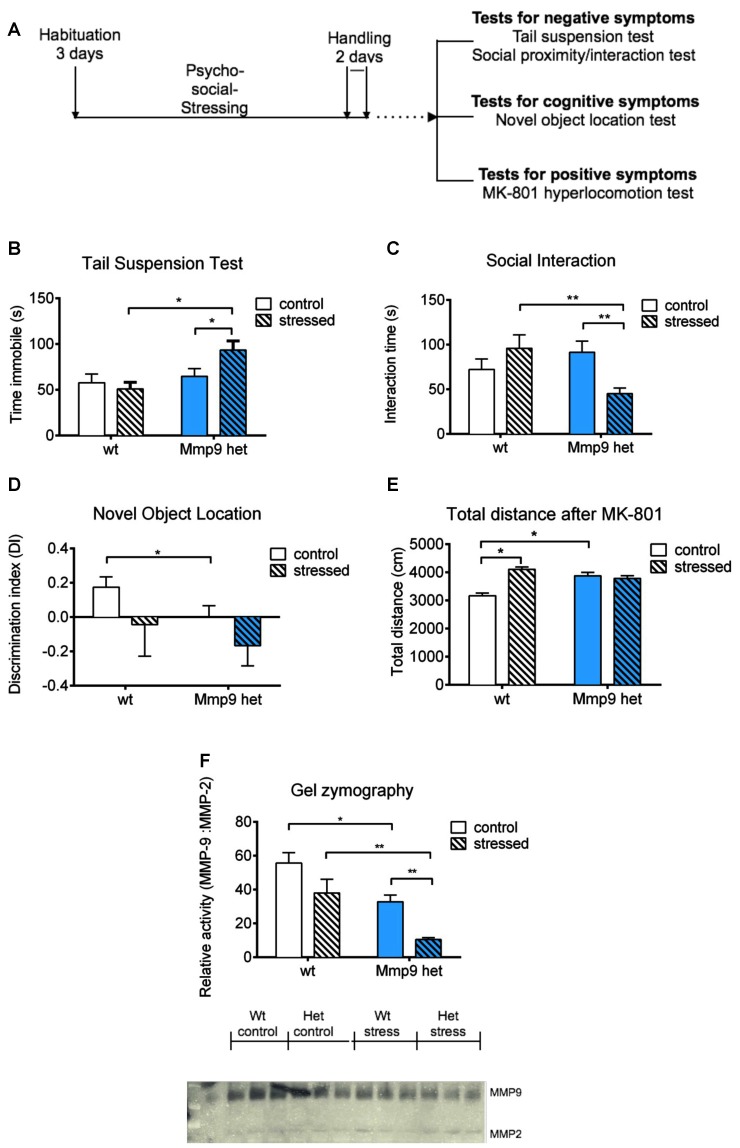
(A) Schematic diagram of the experiment. (B) Tail suspension test. Stressed Mmp-9 heterozygous mice had a longer duration of immobility [individual t-test, p < 0.05; two-way analysis of variance (ANOVA), F(1,37) = 7.008, p < 0.05] compared with their non-stressed counterparts and stressed wt mice. (C) Social interaction test. The time spent interacting with unfamiliar mice decreased in stressed heterozygous mice (individual t-test, p < 0.05; two-way ANOVA, F(1,37) = 8.9555, p < 0.05) compared with their non-stressed counterparts and stressed wt mice. (D) Novel object recognition test. Mmp-9 heterozygous mice spent less time with the novel object (individual t-test, p < 0.05) compared with wt mice. (E) Treatment with MK-801 increases the distance traveled in the open field in heterozygous mice and stressed wt mice (individual t-test, p < 0.05; two-way ANOVA, F(1,37) = 14.61, p < 0.005) compared with non-stressed wt mice. (F) Gel zymography and relative densitometric plot of matrix metalloproteinase-9 (MMP-9) activity normalized to MMP-2 activity. MMP-9 activity significantly decreased (individual U-test, p < 0.05; two-way ANOVA, F(1,8) = 13.9, p < 0.05) after stress exposure compared with the other groups. wt, wt mice; Het, Mmp-9 heterozygous mice. *p < 0.05, **p < 0.01.